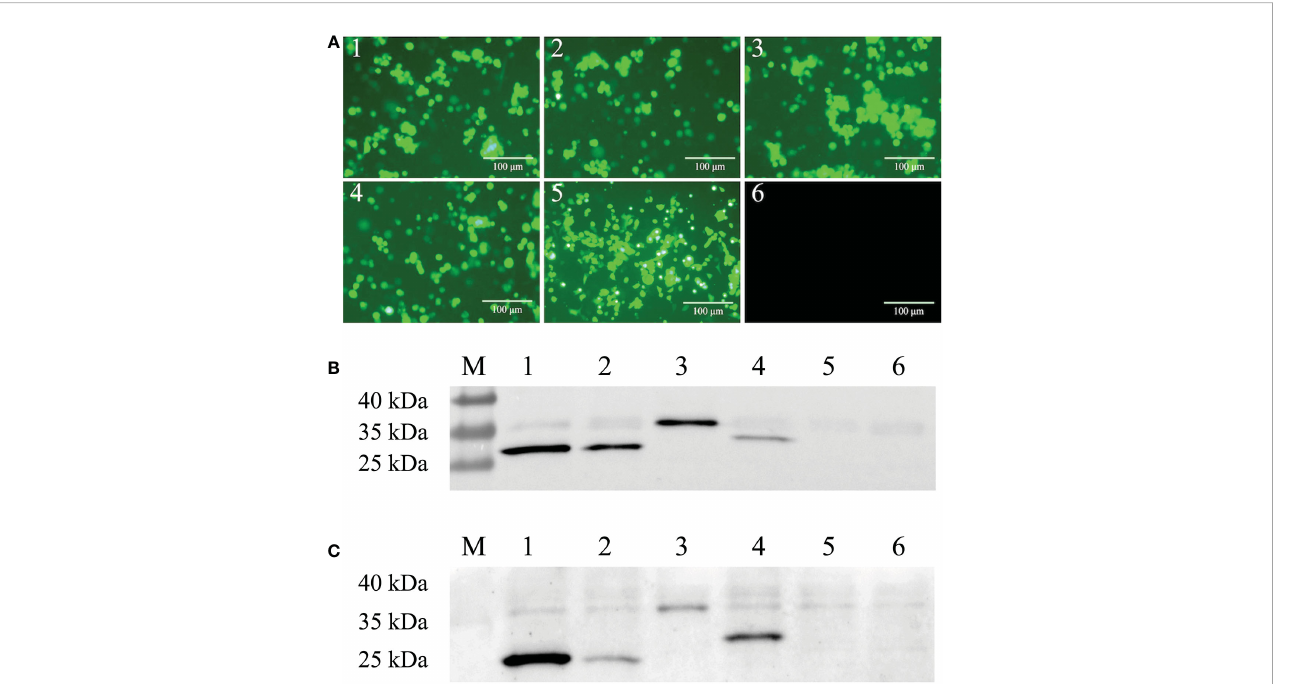
FIGURE 1 Construction of recombinant adenovirus rAdV-scFvs and expression in cells. (A) Fluorescent images of rAdV-scFv-infected HEK293 cells, rAdV-wild-type infected HEK293 cells, and uninfected HEK293 cells. HEK293 cells were infected with rAdV-ZW1-16, rAdV-ZW3-21, rAdV-ZW1-41, rAdV-ZW4-16, and rAdV- wild-type (1 – 5) and observed under fl uorescence microscopy; uninfected HEK293 cells were used as MOCK controls (6). Scale bar = 100 m m. (B, C) Western blots showing scFv expression in HEK293 (B) and IPEC-J2 cells (C) infected with rAdV-scFvs and rAdV-wild type, respectively. Lane M, protein molecular